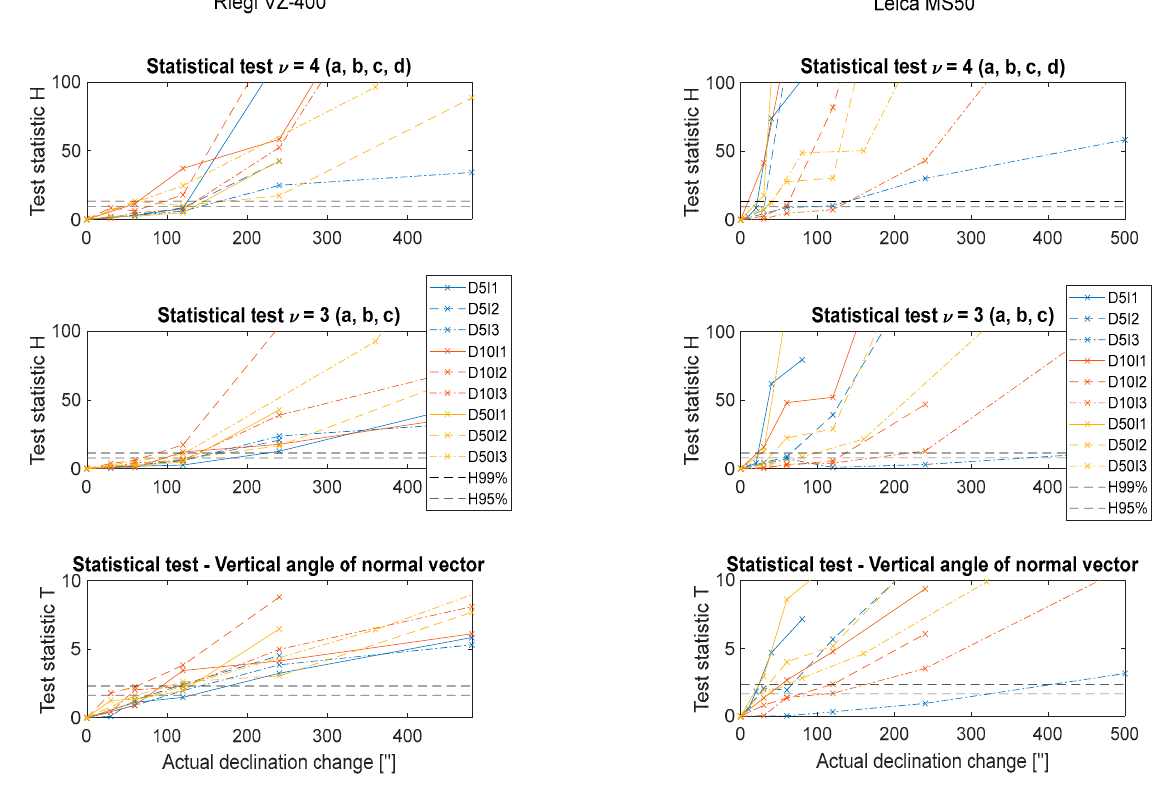
Figure 9. Results of the statistical tests. Blue lines indicate a distance of 5 m, red lines indicate 10 m, and yellow lines indicate 50 m. Full lines correspond to small incidence angles (I1~0 ◦ ), dashed lines to intermediate incidence angles (I2~45 ◦ ), and dotted lines to large incidence angles (I3~75 ◦ ). The X axis represents the actual physical declination of the plane and the Y axis represents the value of the test statistic (Equation (5)). Horizontal dashed lines designate the critical values for 95% and 99% confidence levels.